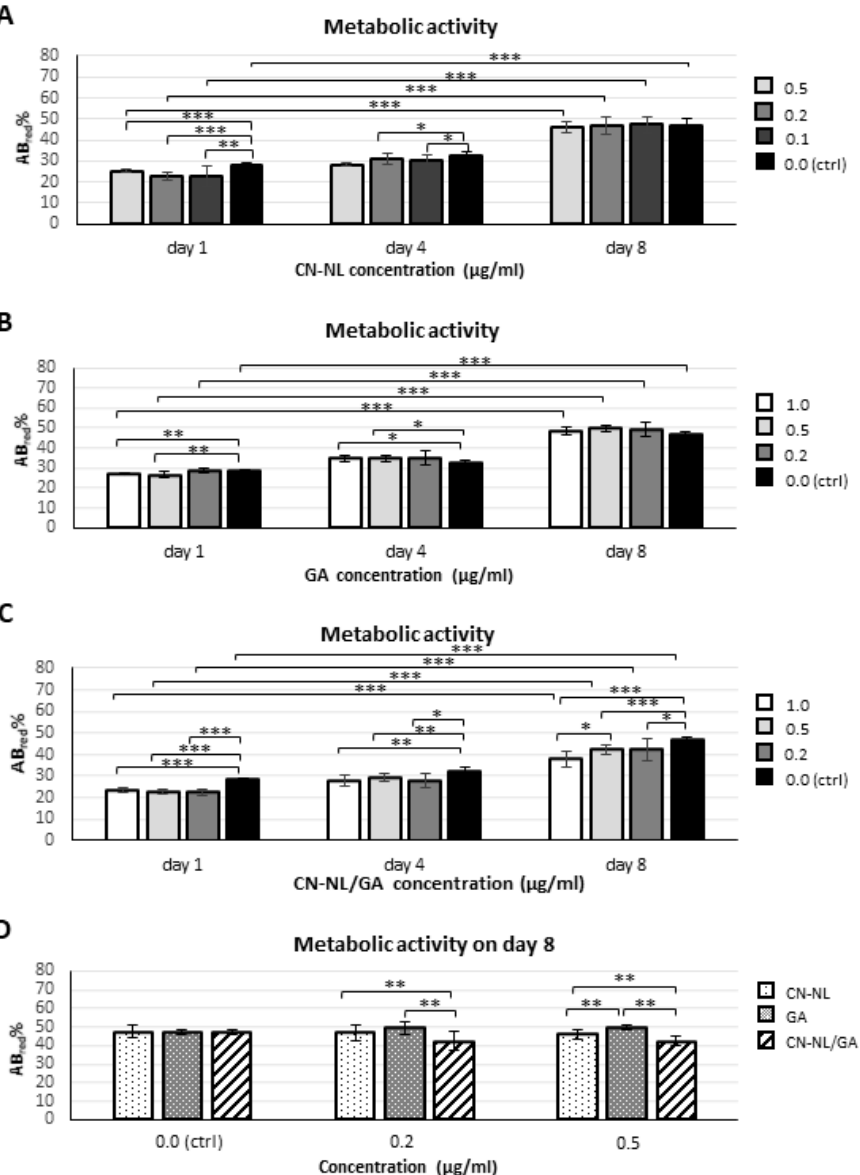
Figure 8. Bar graphs showing metabolic activity, as obtained by alamarBlue® test, performed on undifferentiated hMSCS using CN-NL, GA and CN-LN/GA complexes: ( A – C ) at different time points (1, 4 and 8 days in culture) and selected concentrations for each compound; ( D ) on day 8, comparing the three compounds within homogeneous concentration groups ( * p < 0.01, ** p < 0.001, *** p < 0.0001).